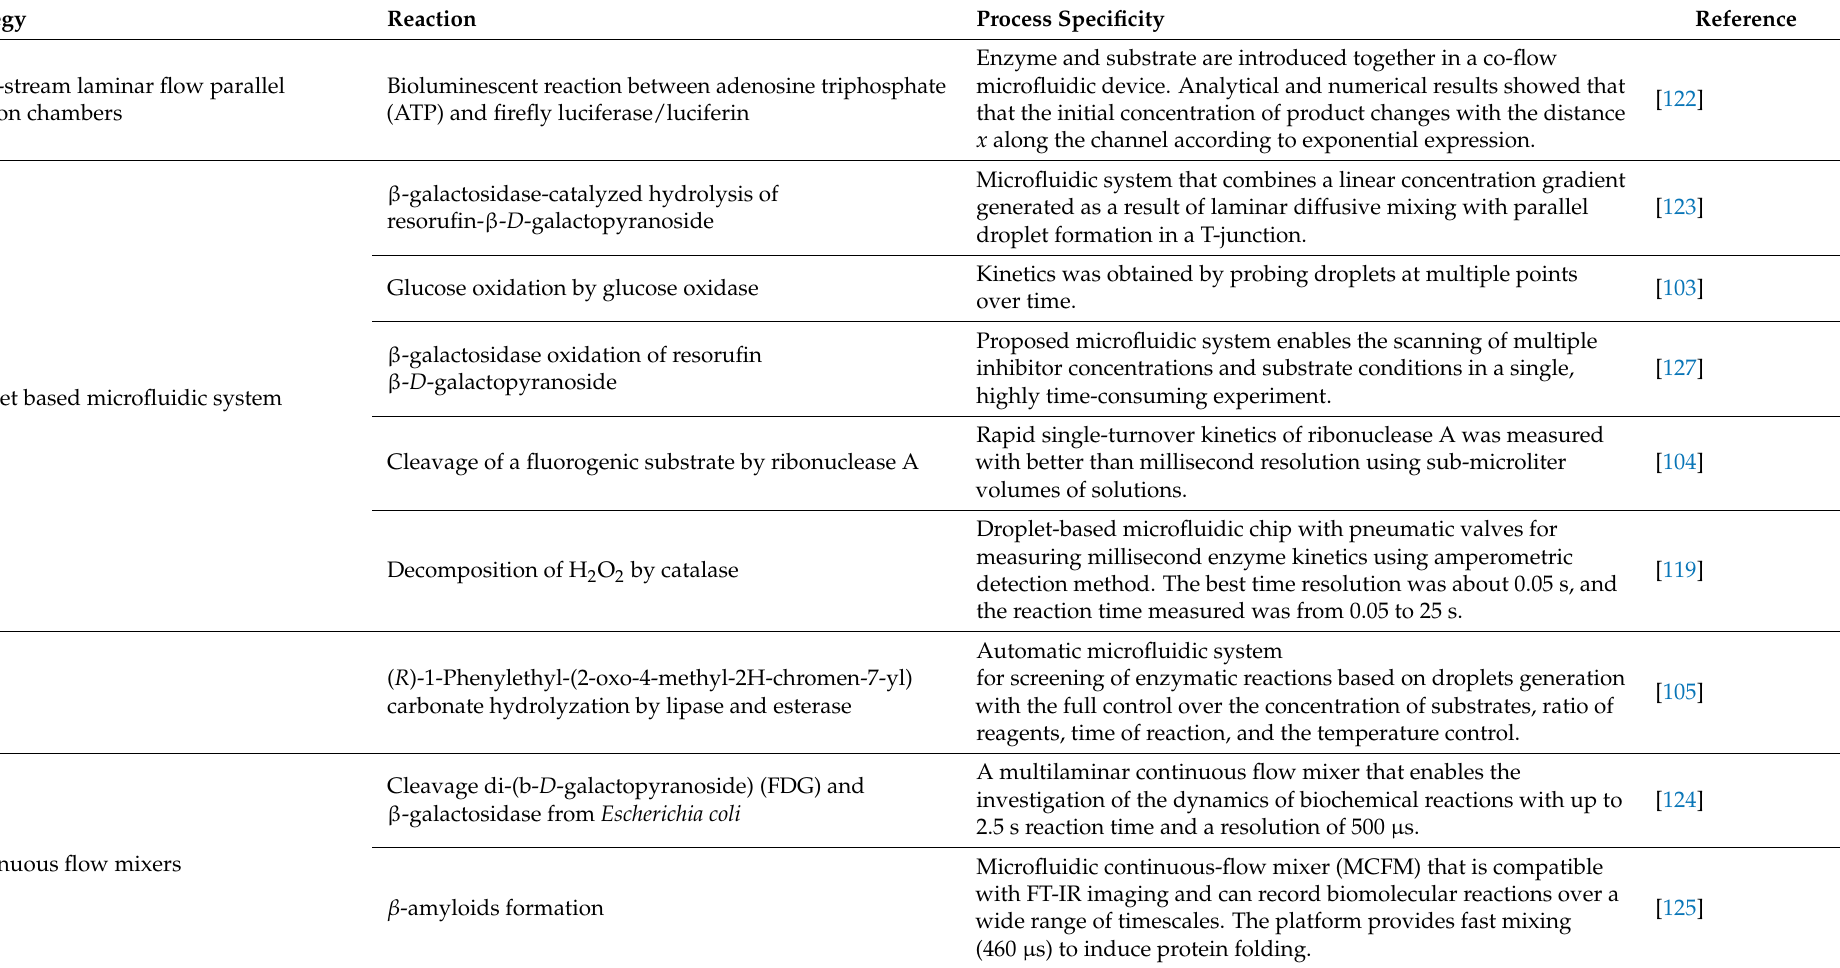
Table 3. Strategies for enzyme kinetics studying in microfluidic